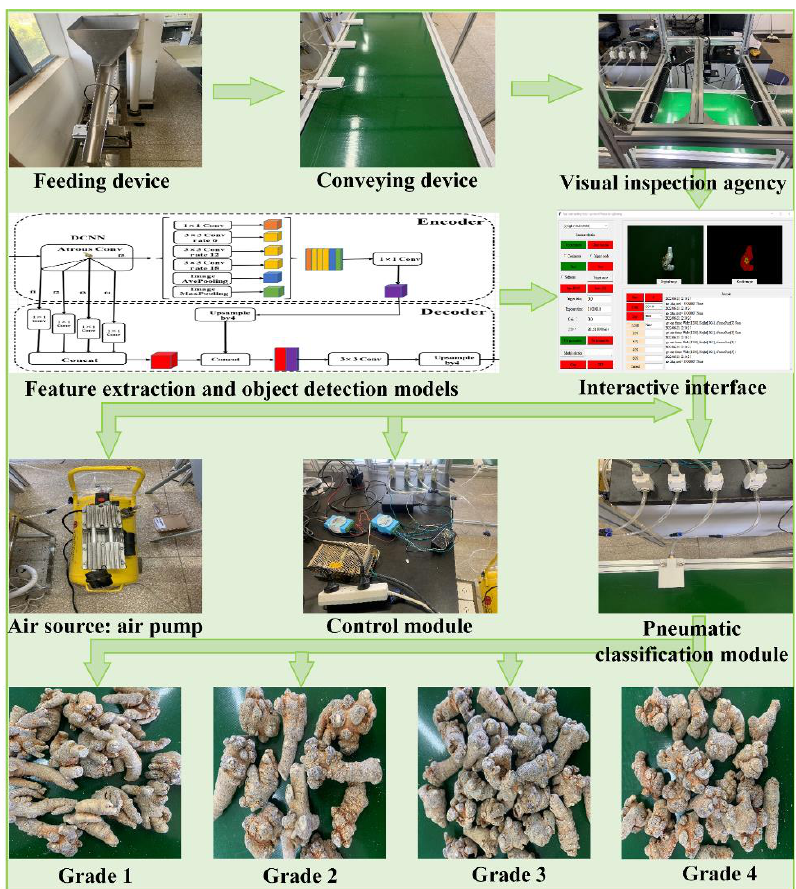
Figure 11. System schematic diagram of the system experiment flow.